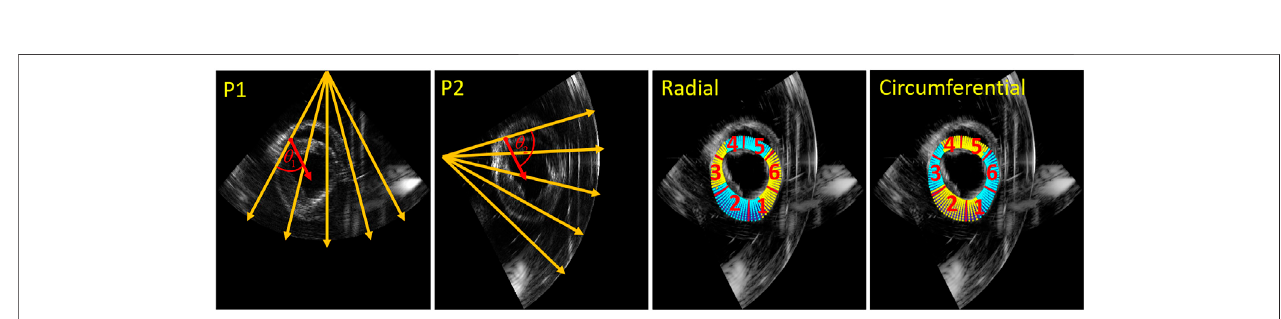
FIGURE 5 | Strain fusion: an example on how to select the optimal radial strain from the two probes for in this case a relative angle of 75 ° ( left two images ). The orangearrowsindicatetheUSbeamdirections,theredarrowsindicatetheradialstraindirectionoftheredpointforthetwoprobesrespectively. θ 1 and θ 2 aretheangles between US beam and the radial strain direction of the red point respectively. Masks for radial and circumferential strain fusion ( right two images ), where cyan means strain selected from P1 and yellow indicates strain chosen from P2. Red numbers show the segmented myocardial regions (11 by 90 samples) for regional strain analysis.